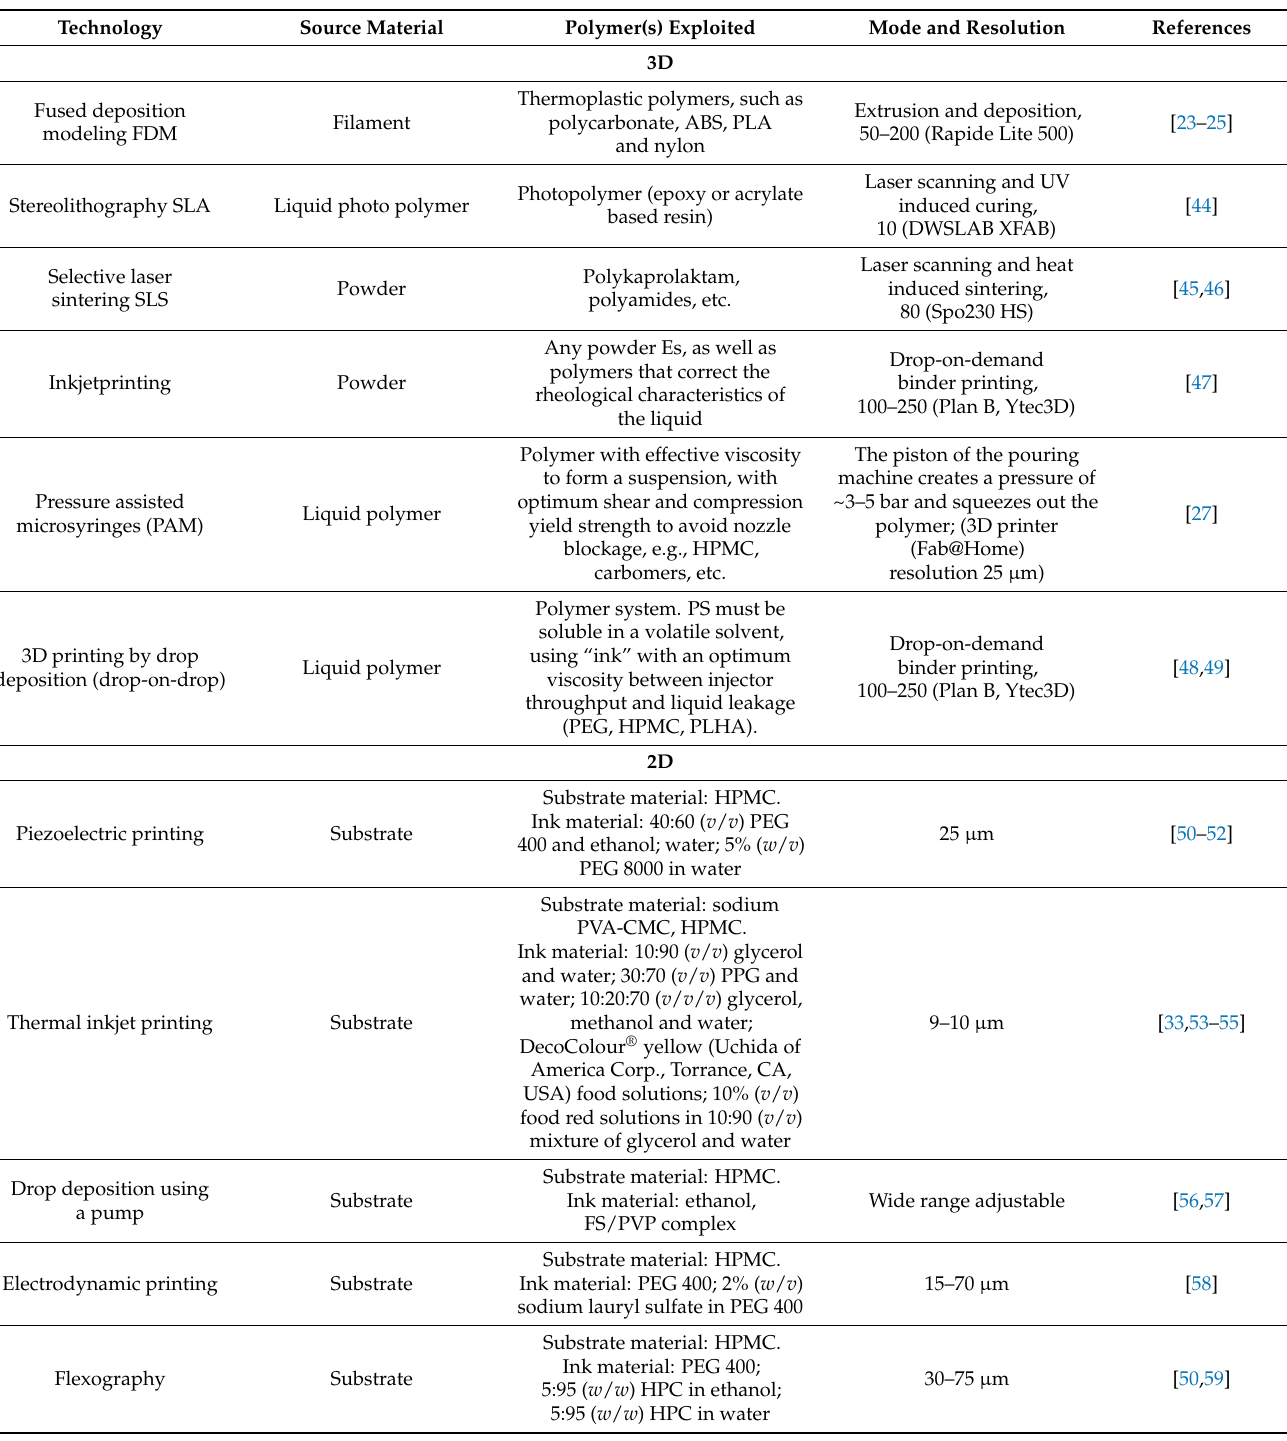
Table 1. Comparative overview of different 2D and 3D printing